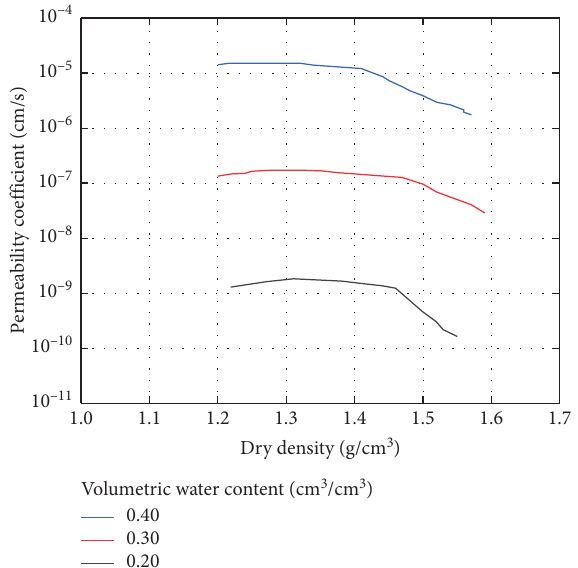
Figure 6: Curve of permeability coefficient with dry density of loess with volumetric liquid water contents of 0.40, 0.30, and 0.20cm 3 / cm 3